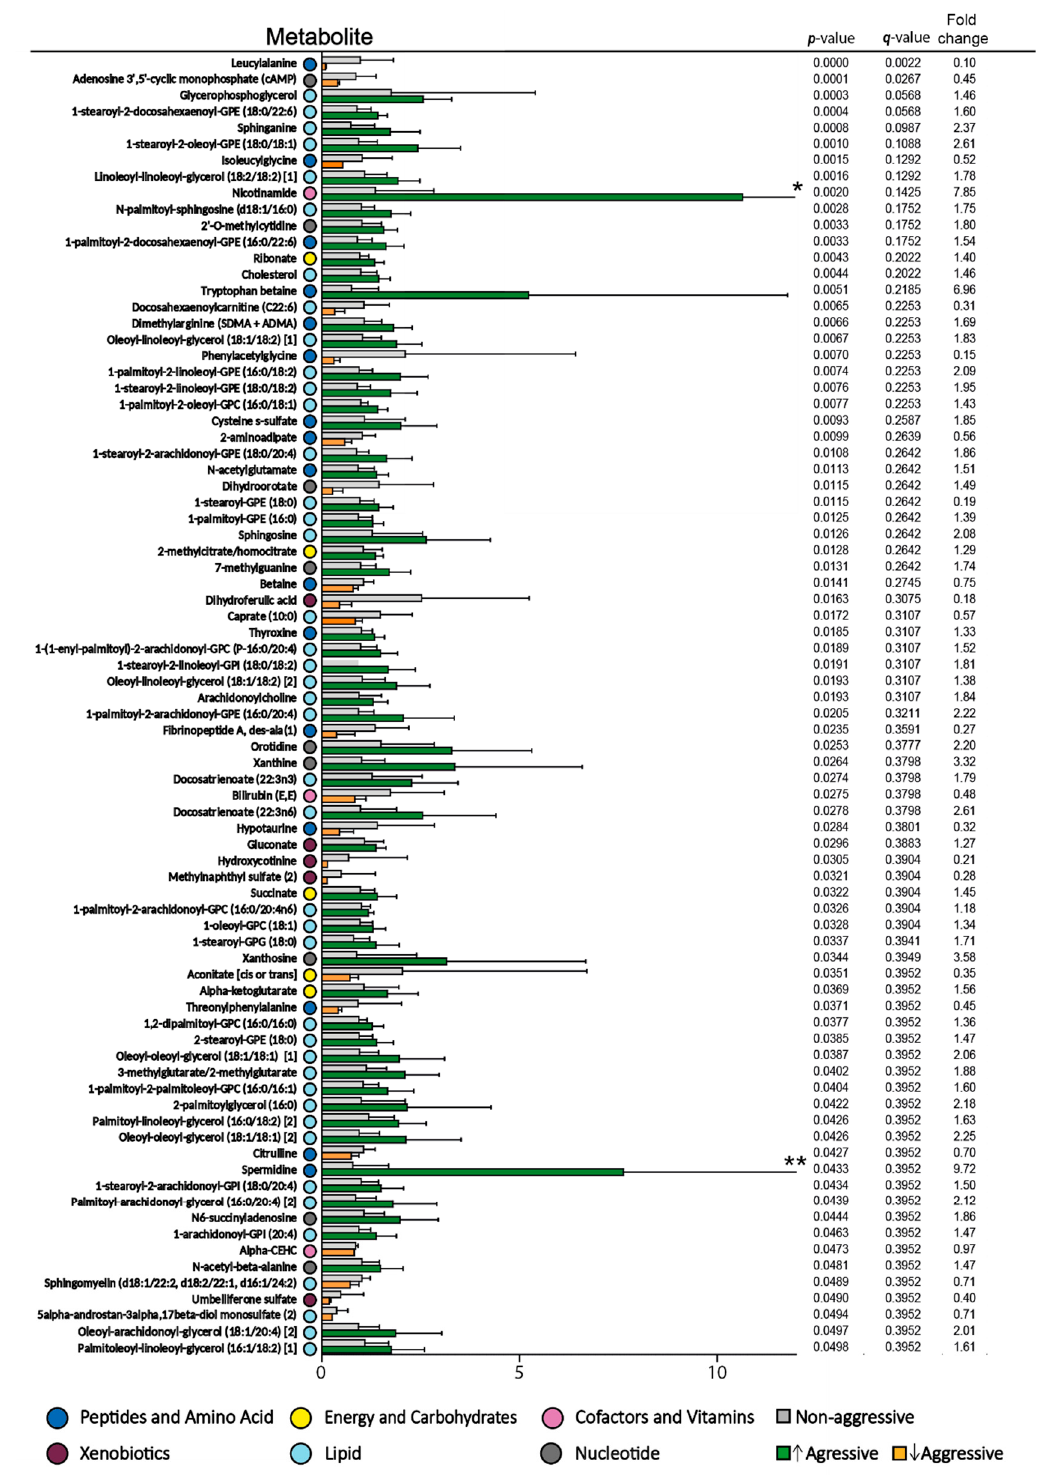
Figure 1. Significantly altered metabolites when comparing the pretreatment levels of non-responders with rapidly progressive disease versus non-responders with less aggressive disease to antileukemic treatment based on all-trans retinoic acid (ATRA) and valproic acid. The p -values, q -values and mean fold change values for each metabolite are listed to the right in the figure (ranked by p -value), and a fold change >1 indicates that the levels were increased in non-responder patients with very aggressive disease compared to non-responder patients with less aggressive disease. Levels of serum metabolites in non-responders with less aggressive disease are shown in grey, increased levels found in non- responders with aggressive disease are shown in green, while decreased levels in non-responders